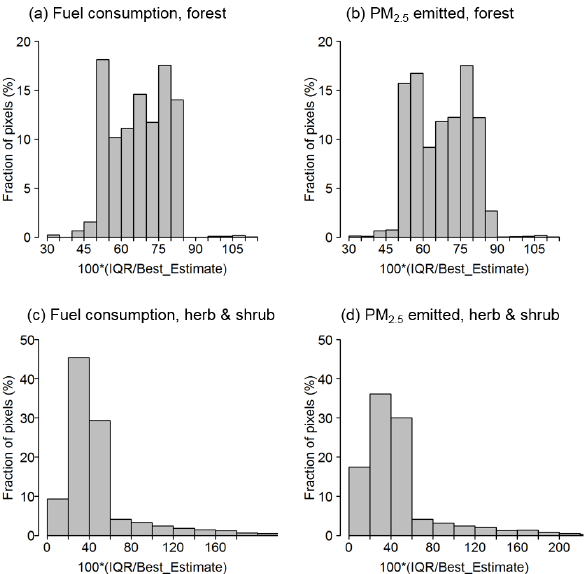
Figure 20. Distribution of relative interquartile range from pixel- level Monte Carlo style